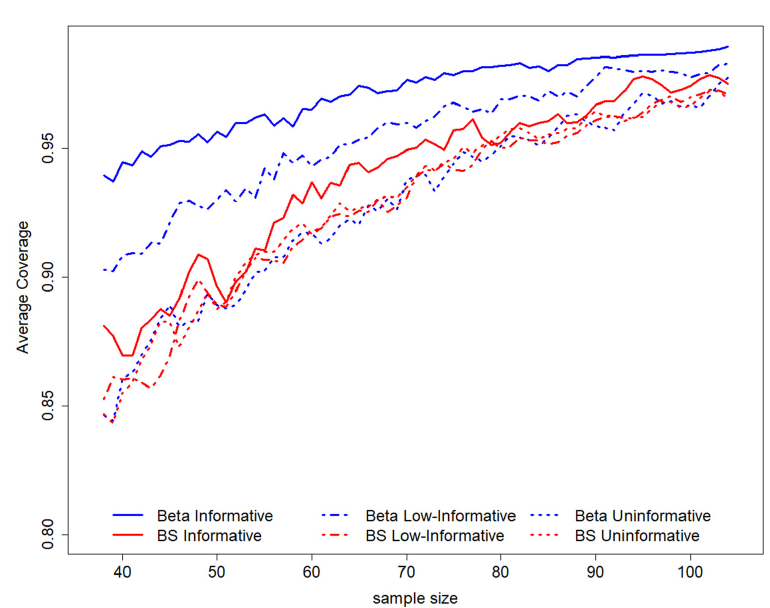
Figure 2. GACC estimation average coverage according to sample sizes for length = 0.2. On the top of the graph, the prior distributions used to perform the study design have been represented. BS stands for B-splines.